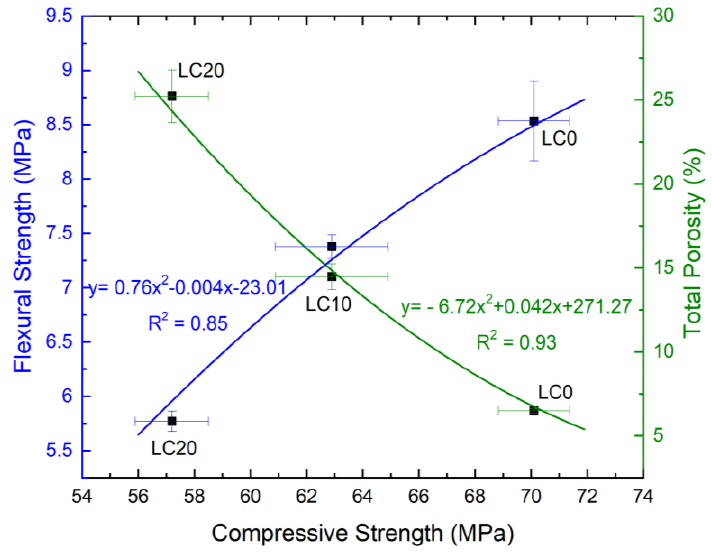
Figure 1. Correlation between compressive strength, flexural tensile strength, and total porosity.